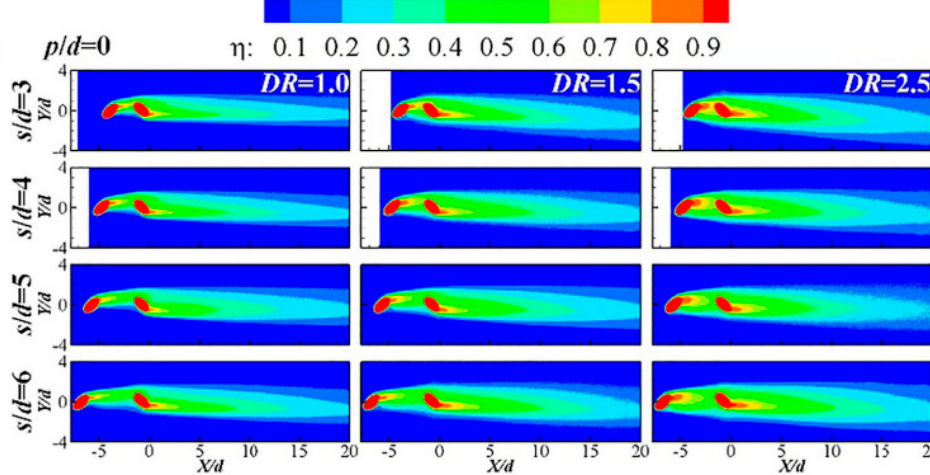
Figure 12. Inclined holes in tandem and the effect of density ratio were shown by Yao et al. [70]. Centerline effectiveness at different blowing ratios and density ratios were presented by [69].